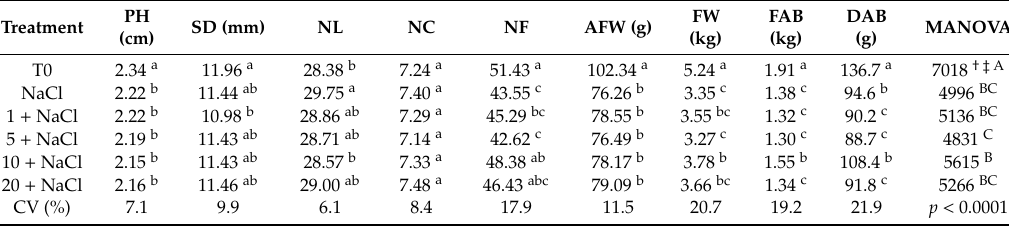
Table 1. Growth variables of tomato plants under NaCl stress and an application of Se nanoparticles (NPs).